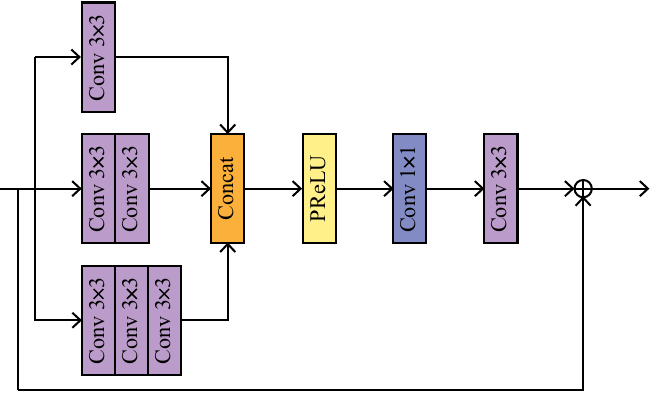
Figure 2. Multi-scale residual block